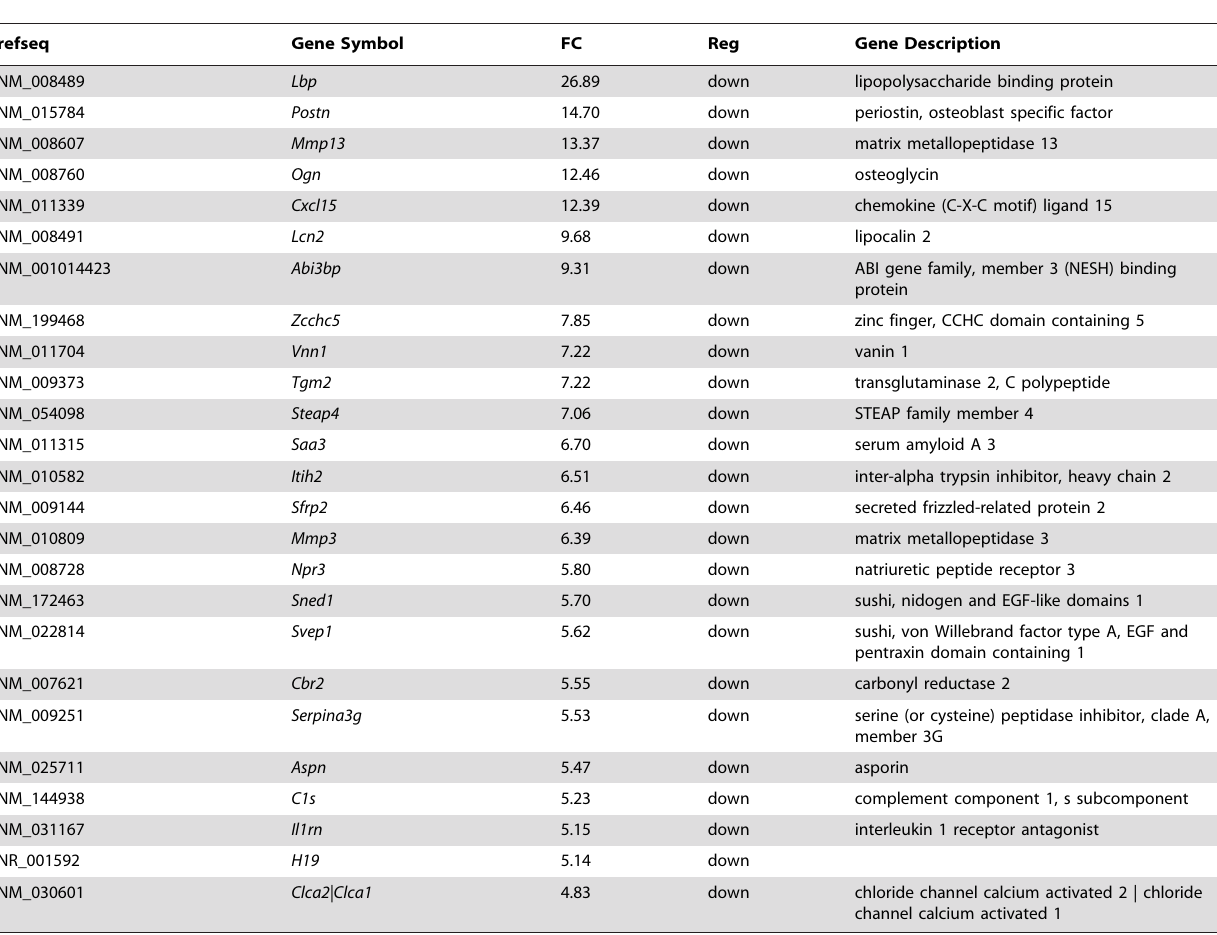
Table 4. Top 25 differentially expressed Affymetrix Mouse Exon 1.0 St Array probe sets between the P53 knock out MEFs and the P53 knock out MEFs in which Mta1 is over